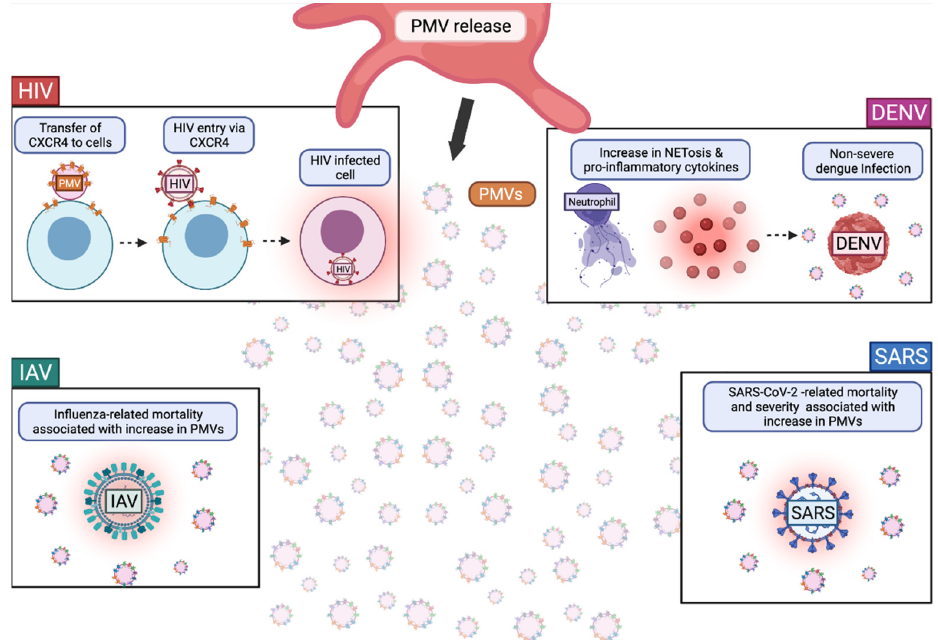
Figure 3. The Role of Platelet Microvesicles (PMVs) in Viral Infection. PMVs are a type of extracellular vesicle derived from activated platelets. In human immunodeficiency virus (HIV) infection, PMVs expressing CXCR4 have been shown in vitro to deliver CXCR4 upon fusion to other cells. Expressing CXCR4 on their surface, these cells are potentially more susceptible to HIV infection, perpetuating disease progression. In dengue virus (DENV) infection, PMVs are associated with increases in neutrophil functions, such as netosis as well as an increase in pro-inflammatory cytokines. Additionally, circulating PMVs are associated with non-severe DENV infection and are reduced in patients with severe disease, suggesting a beneficial role of PMVs in disease resolution. In both influenza A virus (IAV) and SARS-CoV-2 infections, mortality is associated with an increase in PMVs, suggesting a role of PMVs in promoting disease severity. Created with BioRender.com (9 February 2022).